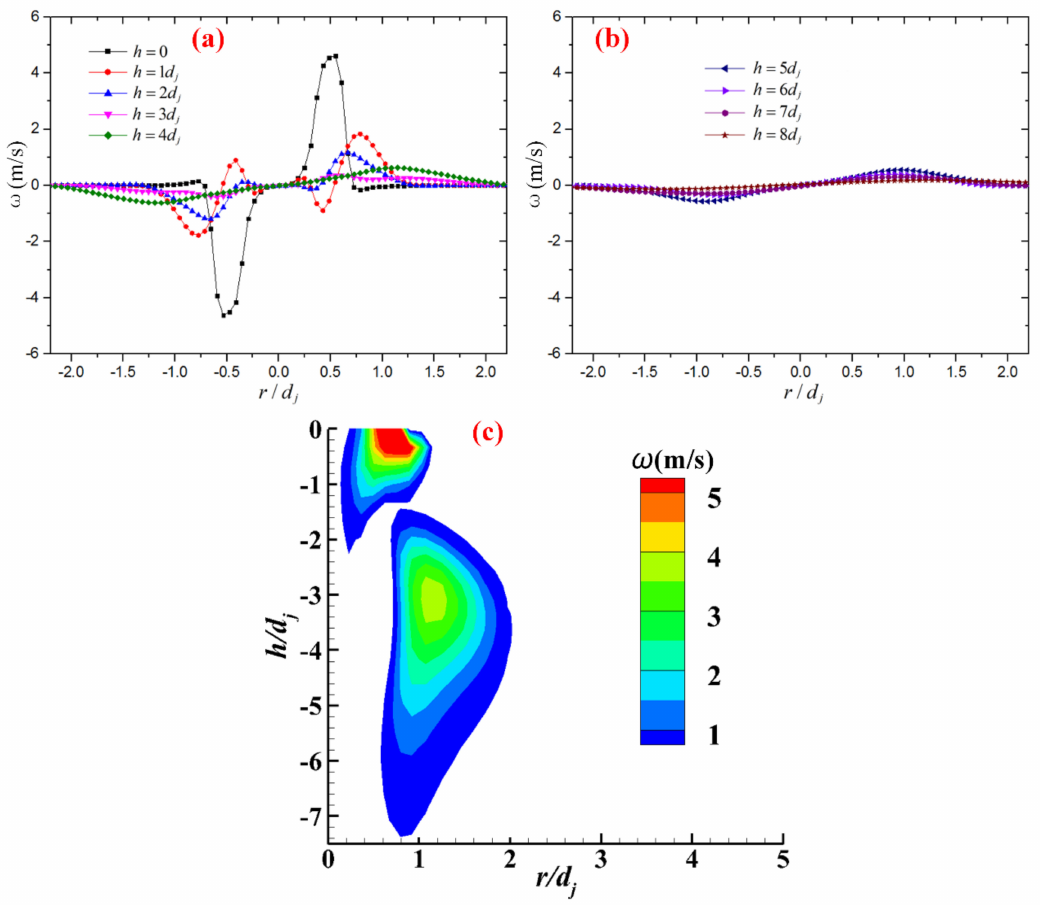
Figure 7. Attenuation curve of tangential velocity: ( a , b ) tangential velocity; ( c ) tangential velocity contour ( Re = 4000, SIJ 45 ◦